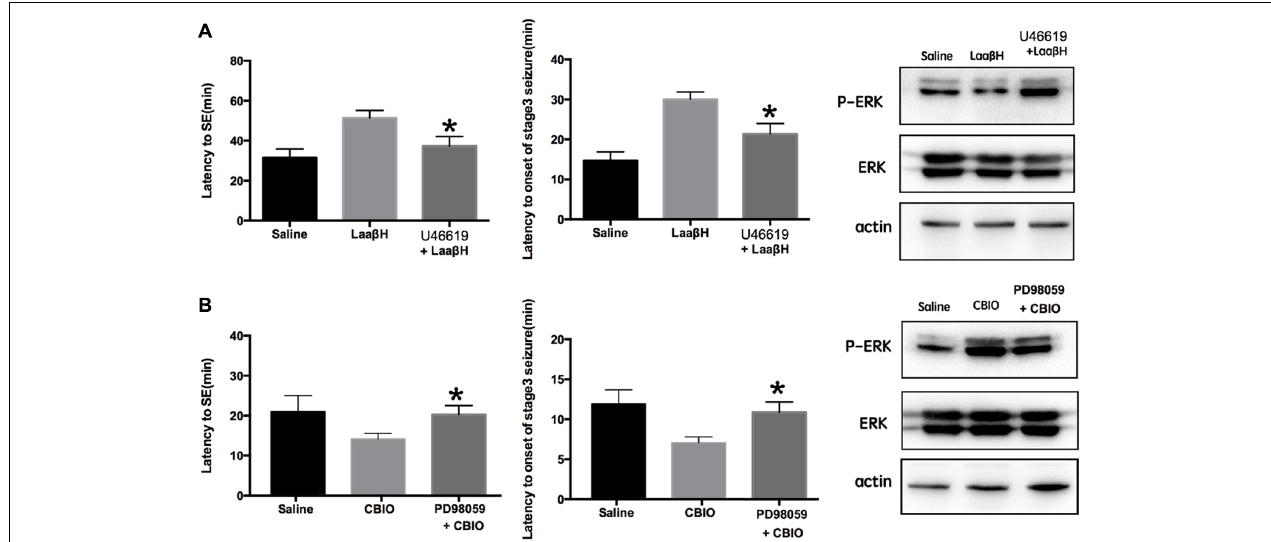
FIGURE 7 | Effects of interfering p-ERK on seizure development in rats treated with D-serine modulators. (A) Effects of the ERK activator U46619 on seizure development and p-ERK/ERK expression in rats treated with Laa β H, compared with rats treated with Laa β H alone. N = 5 rats per group. (B) Effects of the ERK inhibitor PD98059 on seizure development and p-JNK/JNK expression in rats treated with CBIO, compared with rats treated with CBIO alone. N = 5 rats per group. Notice that the ERK activator could block the effects of Laa β H and the ERK inhibitor could block the effects of CBIO. ∗ P < 0.05.